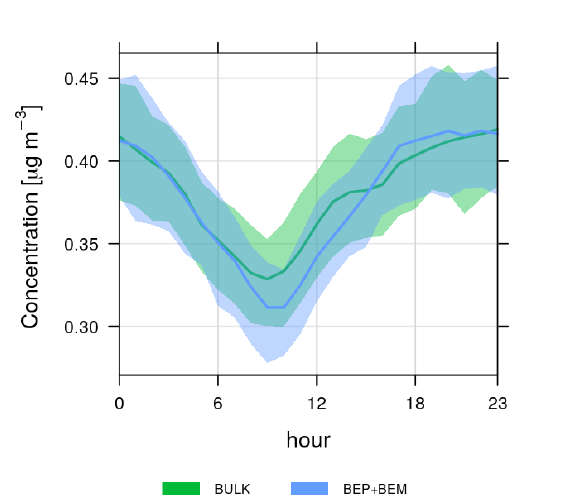
Figure 13. Averaged diurnal profiles of PM secondary organic aerosol for BULK simulations (green) and BEP+BEM simulations (blue). Lines represent the mean values and shaded areas the 95% confidence interval in the mean.